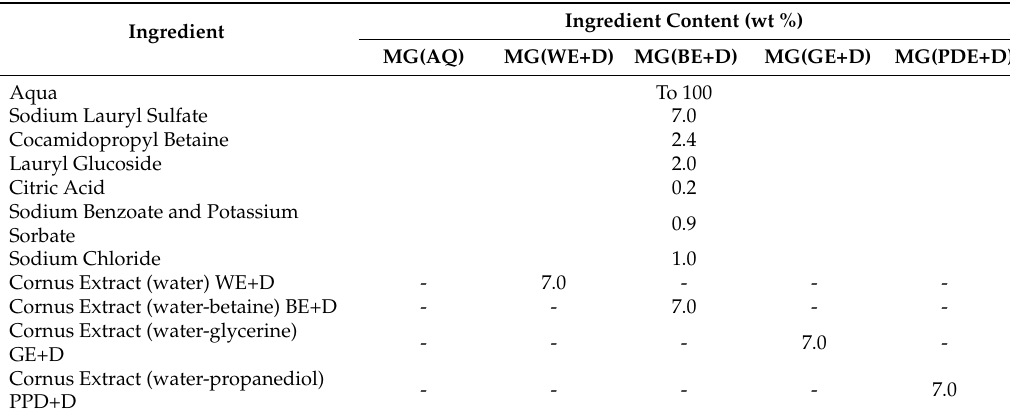
Table 1. Formulation of model body wash